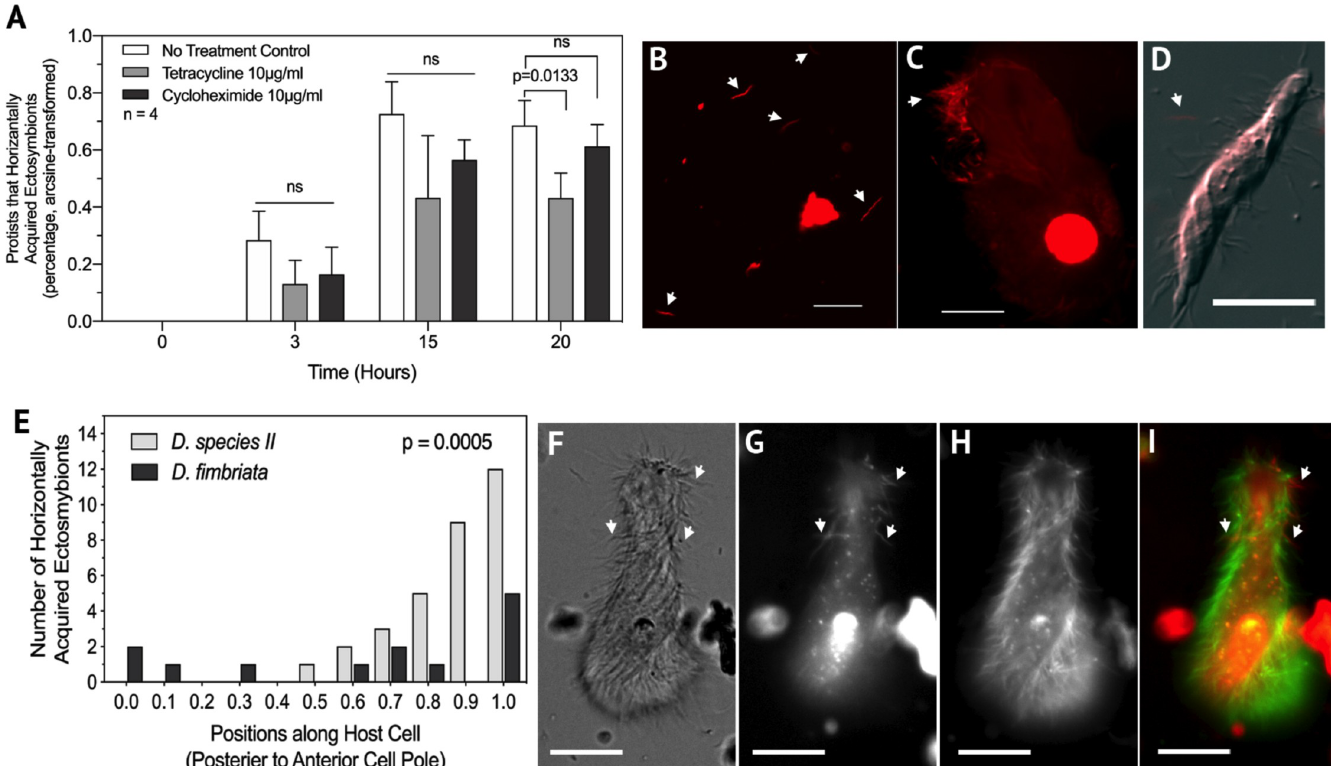
Fig 4. Horizontal transmission of ectosymbionts involves active processes and is non-random. (A) The addition of tetracycline significantly lowered the percentage of protists that acquired at least one new ectosymbiont (Two-tailed T-test, Time = 20 hours, t = 5.278, df = 3, p = 0.0133, n = 4 independent experiments, Benjamini- Hochberg P-value = 0.0804 see FDR Statistics in S1 File) while the addition of cycloheximide had no significant effect. (B—D) Micrographs of propidium iodide stained cells. Exposing hindgut contents to O 2 killed hindgut bacteria (B and C) which did not bind to live protist cells (D) (arrows point to O 2 killed bacteria). (E) Significantly more ectosymbionts (Pearson’s R, p = 0.0005) bound towards the anterior cell pole compared to the posterior cell pole on D . species II however, this binding characteristic was not seen in other Dinenympha species. (F—I) Fluorescence and DIC micrograph of D . species II stained with amine reactive dyes (G TRSE, H SE488), showing increased binding of new ectosymbionts (arrows) toward the anterior cell pole. Scale bars represent 10 μ m.